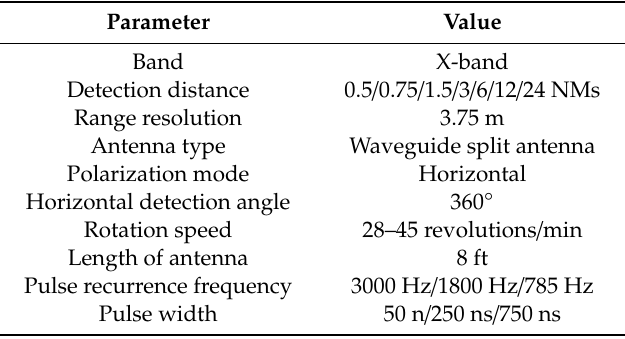
Figure 5. Installation of the ship-borne radar oil spill data acquisition system onboard the Yukun [26].